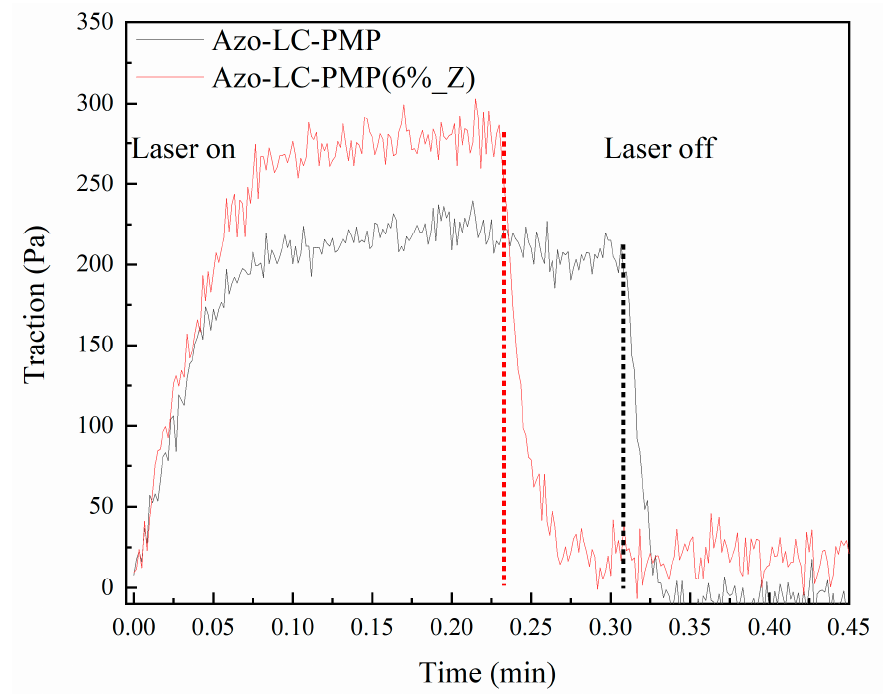
Figure 9. Traction ability of the PMPs when irradiated by the laser. The power density was 2.4 W/cm 2 . The laser starts to irradiate the sample at 0.0 min and stops on the dotted line.